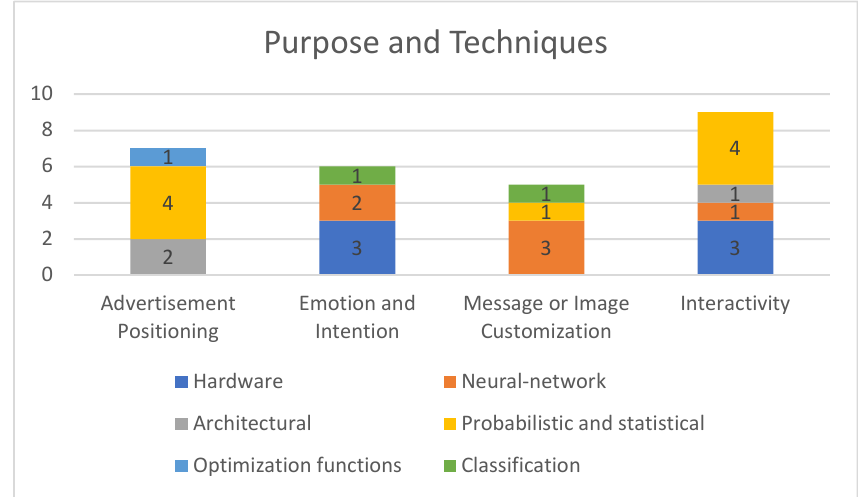
Figure 8. Purpose and techniques used.